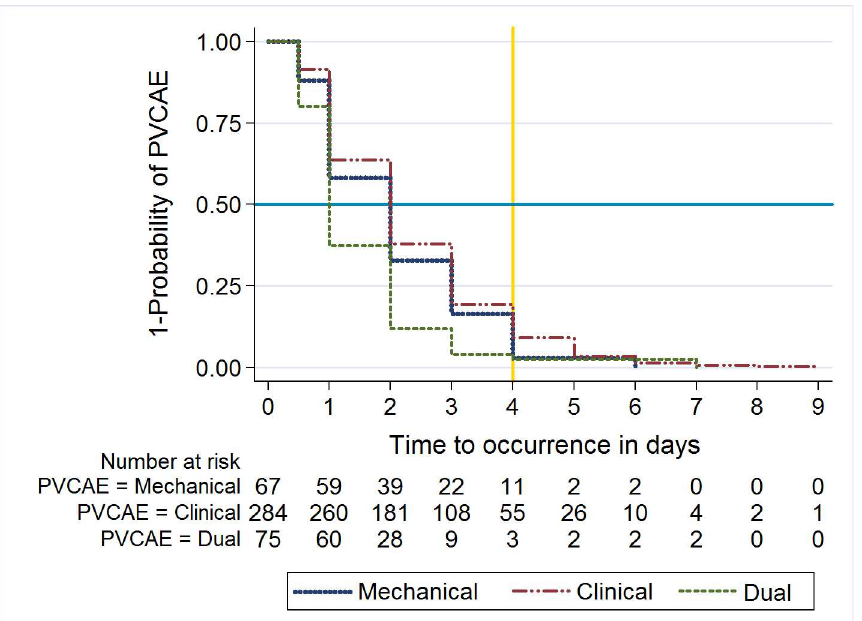
Fig 1. Kaplan-Meier estimates of time to first PVC-related adverseevent occurrence per event class. Legend : Kaplan-Meier estimates took into account only PVCs with at least one adverseevent in order to comparetime accordingevent class, includingthose occurredduring post-removal follow-up. The blue line represents the 50% mark and the yellow line the recommended delay for routine removalof PVCs. PVC: Peripheral venous catheter; PVCAEs: PVC-related adverse events. Note: MechanicalPVCAEs could occur only during indwellonly.